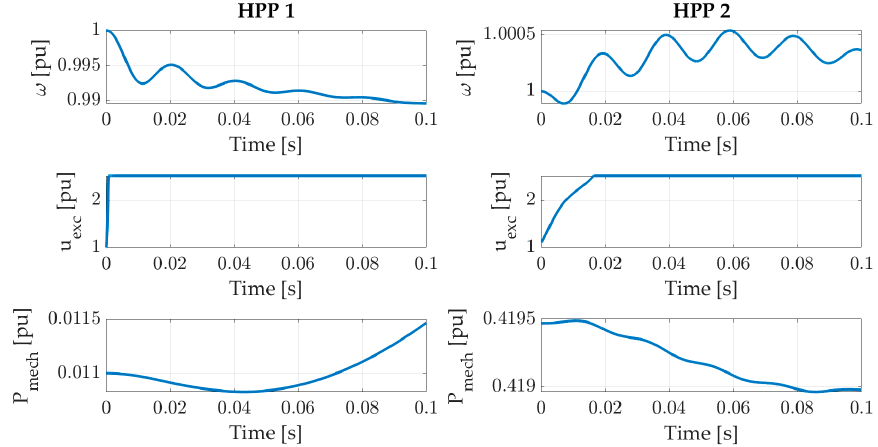
Figure 16. Machine speed, excitation voltage, and mechanical